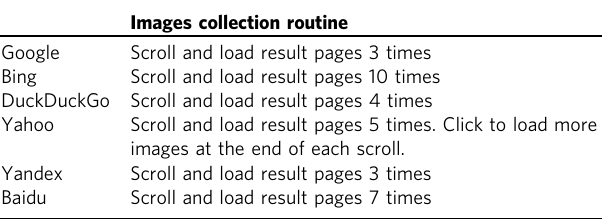
Table 1 Bot navigation routines for image collection by search